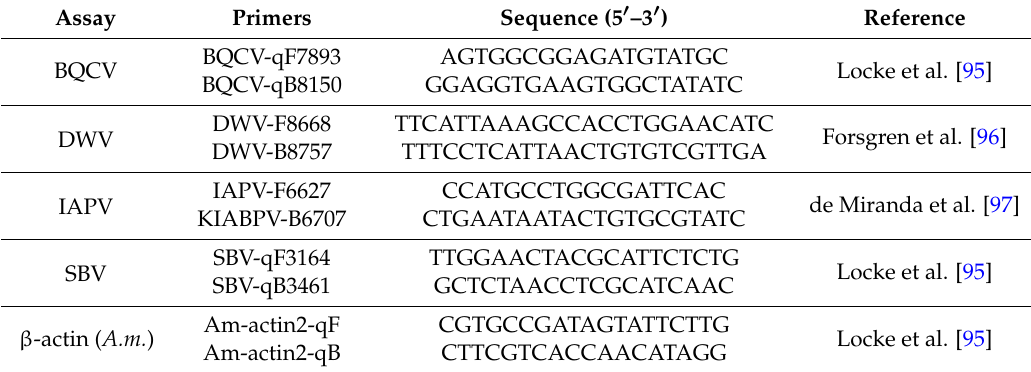
Table 1. Primers, sequences, and references used for quantification of the honeybee viruses black queen cell virus (BQCV), deformed wing virus (DWV), Israeli acute paralysis virus (IAPV), and sacbrood virus (SBV). Target virus genes were quantified in relation to a non-regulated Apis mellifera ( A. m. ) reference gene ( β -actin analyzed in parallel in each